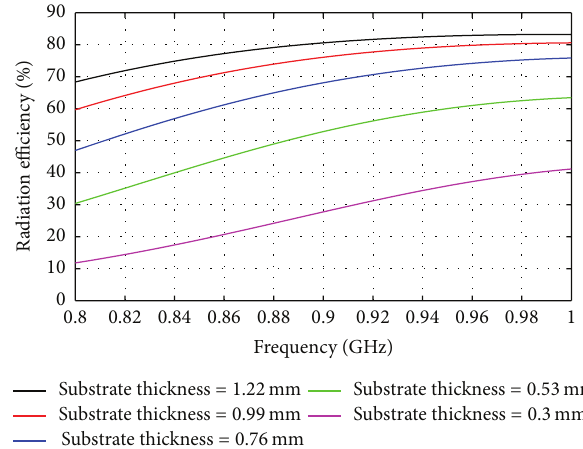
Figure 15: Radiation efficiency of directly fed coupled shorted patches with tuning slots as a function of the height of the patch